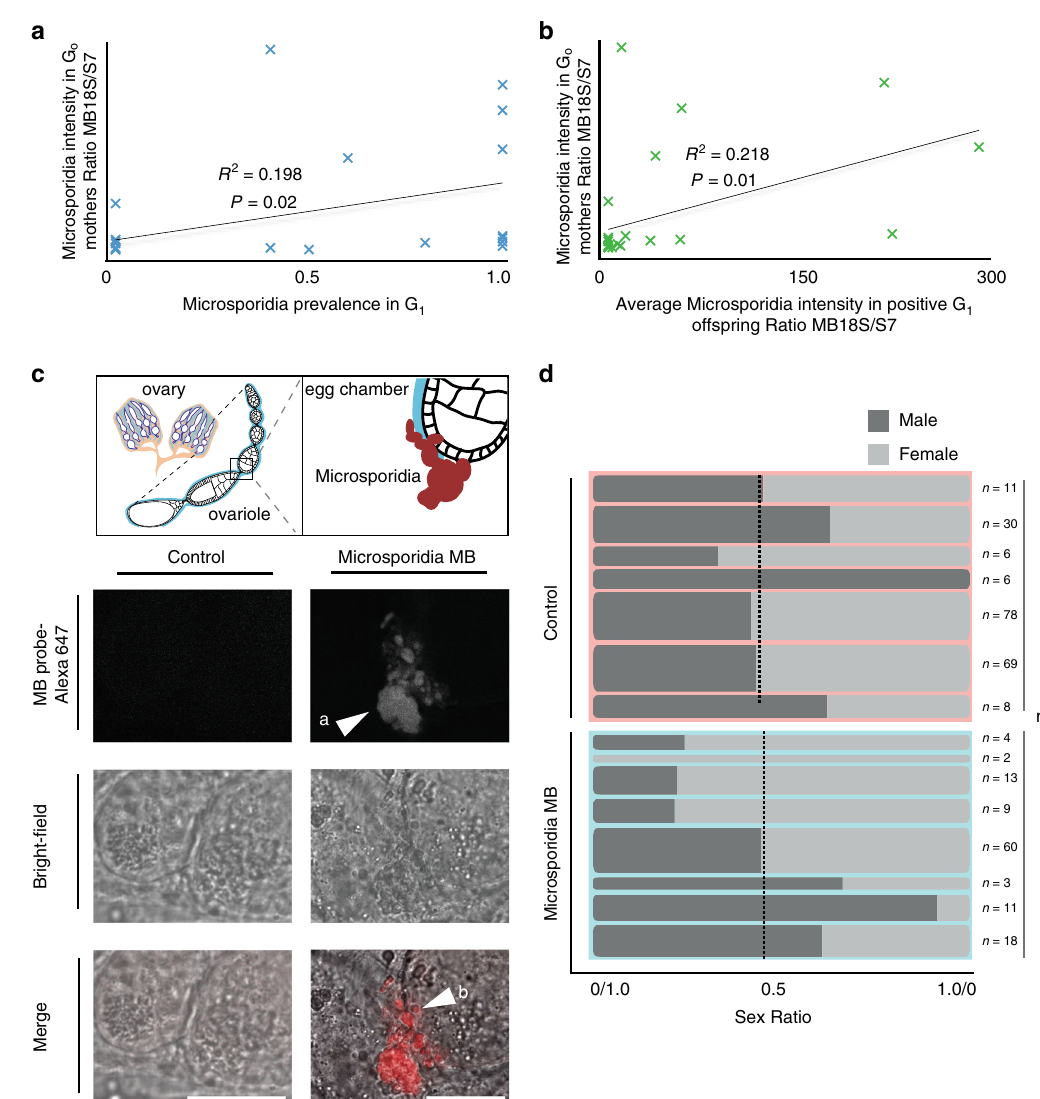
Fig. 3 Microsporidia MB is maternally transmitted and does not bias sex ratio. a The vertical transmission ef fi ciency of Microsporidia MB to G 1 depends on the G 0 (maternal) Microsporidia MB intensity. In a linear regression, the slope is signi fi cantly non-zero ( P = 0.02, F = 6.169, and n = 27). b The intensity of Microsporidia MB in G 1 offspring is correlated to G 0 maternal intensity, with a linear regression the slope that is signi fi cantly non-zero ( P = 0.01, F = 6.98 and n = 27). c Fluorescence microscopy with a Microsporidia MB speci fi c FISH probe (MB probe) indicates that Microsporidia MB ( a ) is localized to the posterior of developing vitellogenic egg chambers ( b ) in An. arabiensis . Scale bar, 20 μ m. Representative images as observed in three independent experiments. d The sex ratio of broods from Microsporidia MB infected mothers does not differ signi fi cantly from Microsporidia MB uninfected mothers suggesting there is no sex ratio distortion (Unpaired two-tailed t -test, P = 0.32, t = 1.02, df = 13). Dashed line re fl ects overall sex ratio (Uninfected control = 100:108 or 52% female, Microsporidia MB = 56:64 or 54% female). Column widths re fl ect sample sizes Source data are provided as a Source Data fi